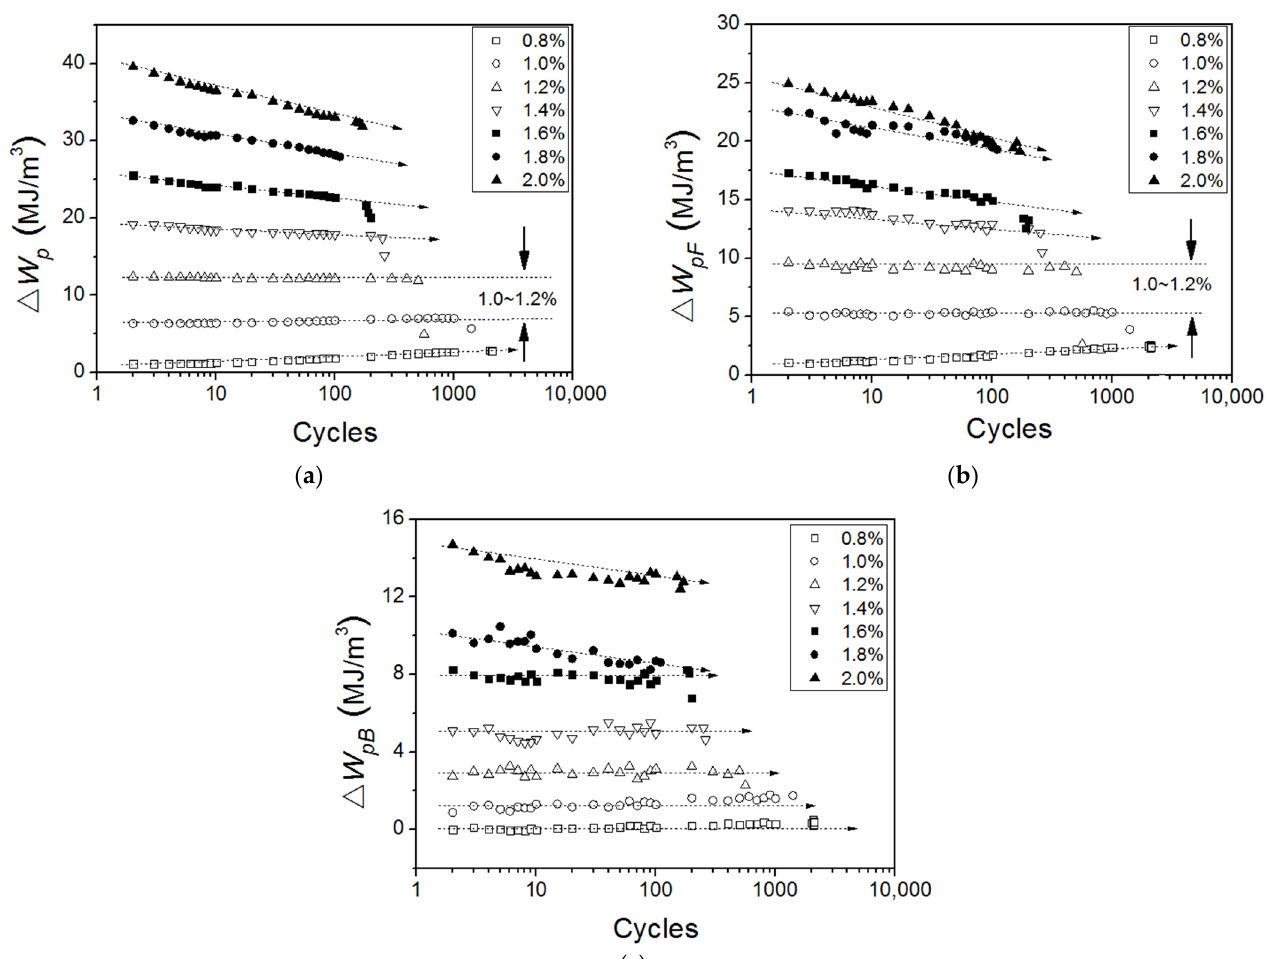
Figure 13 . The evolution of ( a ) ∆ W p , ( b ) ∆ W pF and ( c ) ∆ W pB with cyclic numbers.